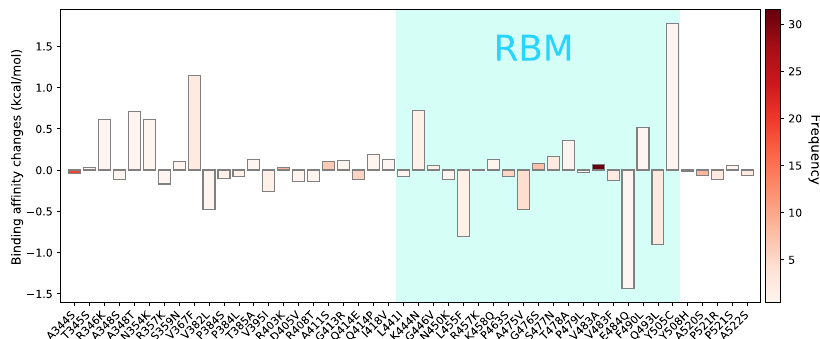
Fig. 7 Overall binding free energy changes ΔΔ G (kcal/mol) on the receptor-binding domain (RBD). The blue color region marks the binding free energy changes on the receptor-binding motif (RBM). The height of each bar indicates the predicted ΔΔ G . The color indicates the occurrence frequency in the GISAID genome